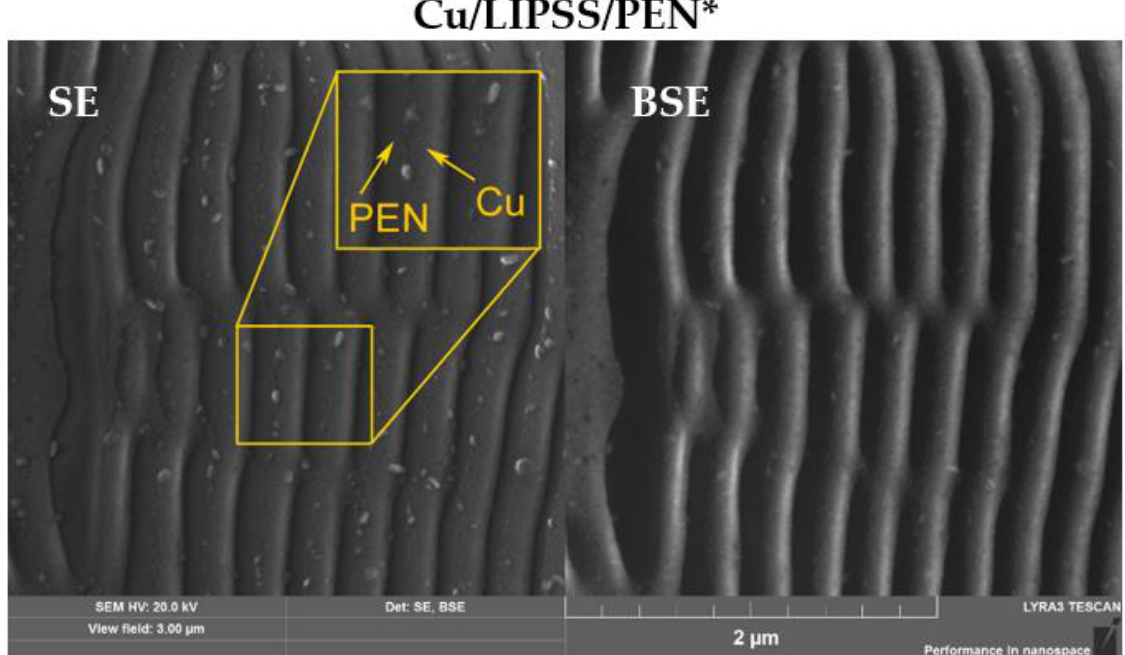
Figure 2. SEM micrographs of Cu nanowires supported on PEN with a highlighted Cu-PEN inter-